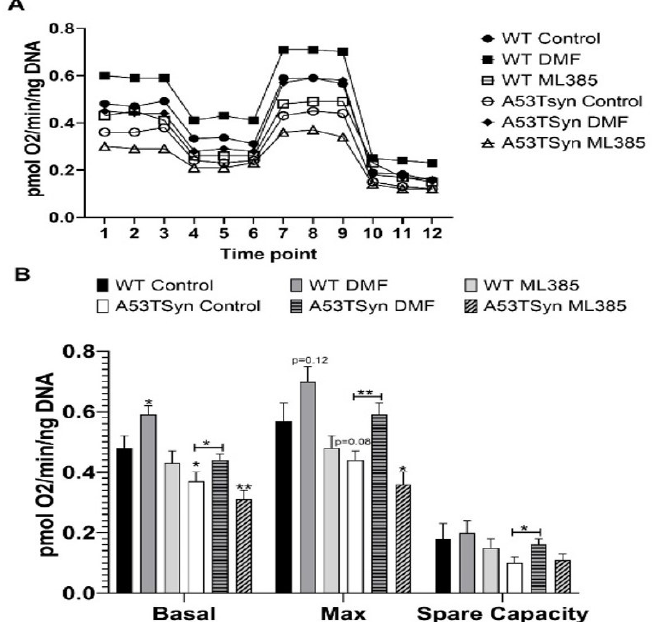
Figure 3. Deficits in mitochondrial respiration in A53TSyn neurons are attenuated by DMF and exacerbated by ML385. ( A ) Differences were observed in the bioenergetic profile of A53TSyn and WT neurons and further altered by treatment with DMF and ML385. ( B ) DMF treatment increased basal and maximal respiration as well as spare capacity in A53TSyn neurons. In WT neurons basal respiration was increased by DMF but otherwise unaffected by treatment. Significance is relative to control unless otherwise indicated ( * p < 0.05, ** p < 0.01).